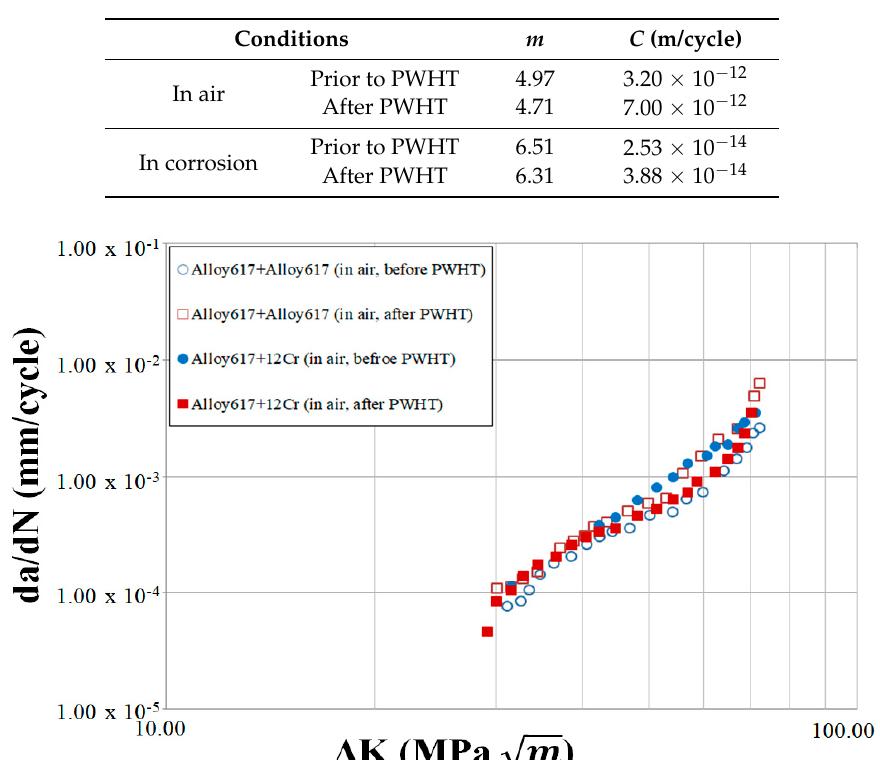
Table 10. Experimental estimation of C and m of Paris’ law.